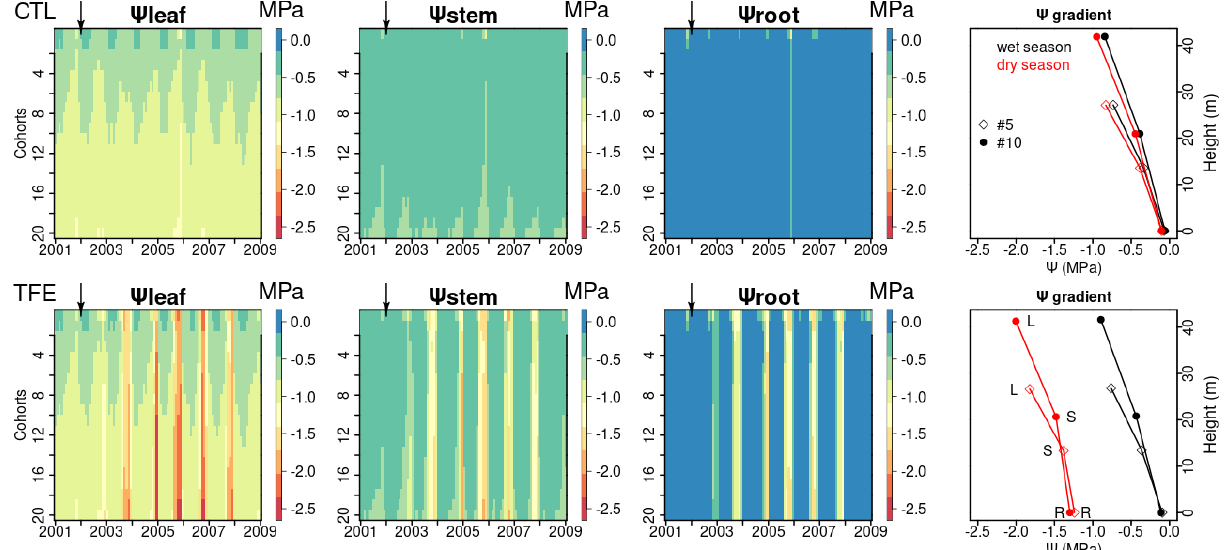
Figure 7. (cid:57) leaf , (cid:57) stem , and (cid:57) root simulated by ORCHIDEE-CAN-NHA. Water potential gradients of two cohorts (#5, #10) are shown as an example (May 2005 as the wet season and November 2005 as the dry season). Here, the cohort refers to the circumference class (mean height of #5 and #10 are 19 and 35m, respectively). The water potential gradient is composed by (cid:57) leaf (labeled as L), (cid:57) stem (labeled as S) and (cid:57) root (labeled as R). The heights of (cid:57) leaf and (cid:57) stem correspond to tree height and half of tree height, respectively.